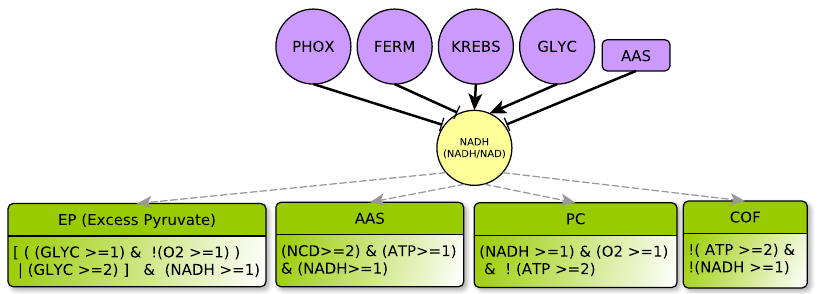
Figure 11. resources and target for NADH